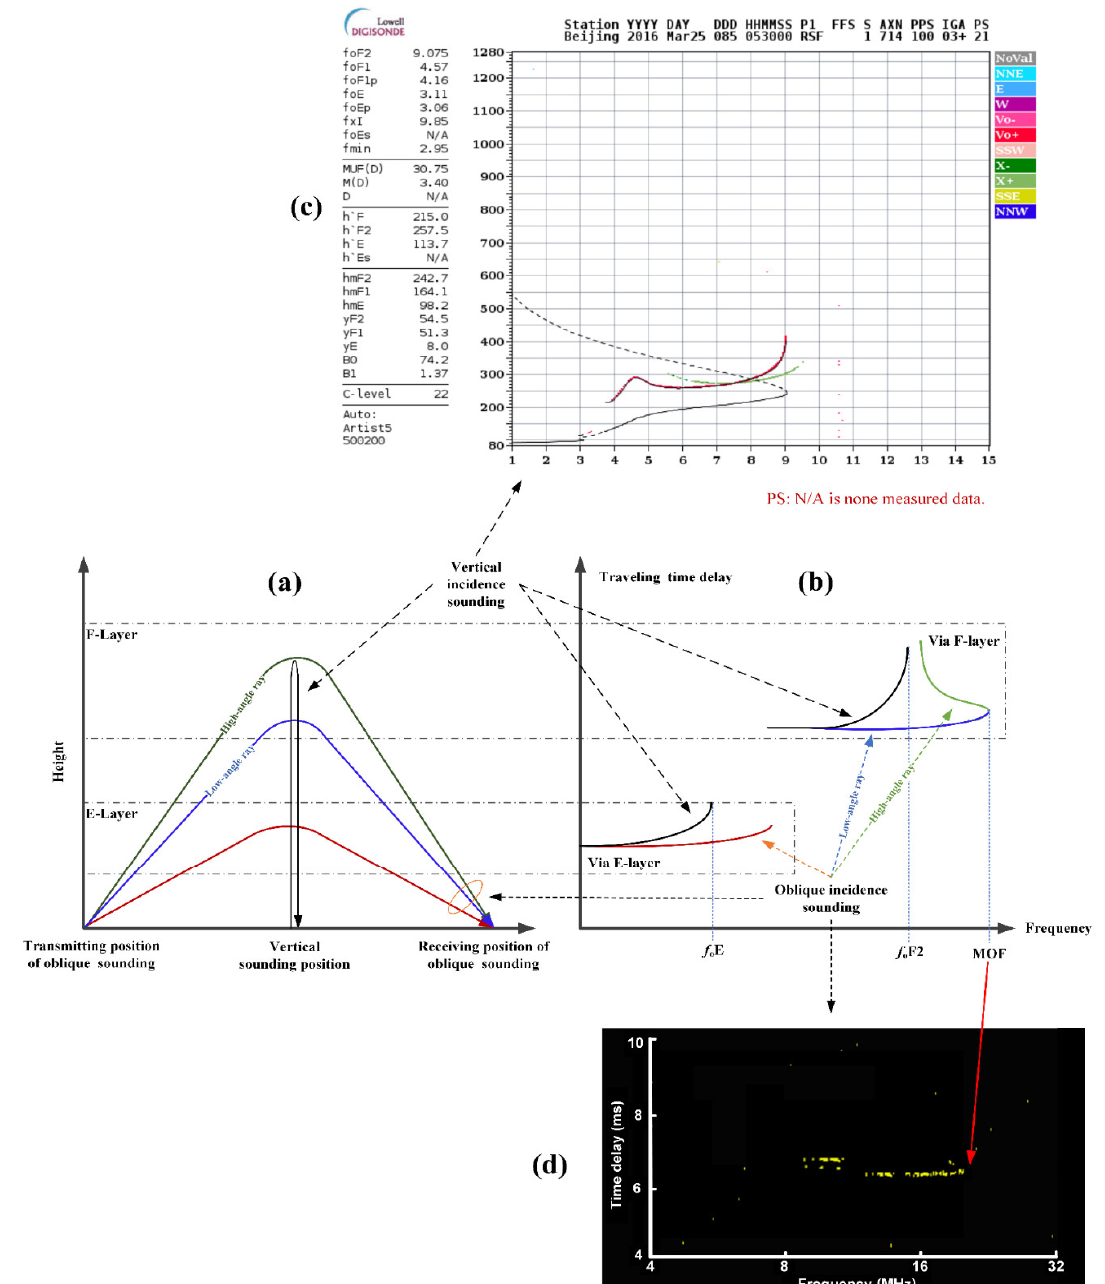
Figure 1. Principle and output results of the VI and OI sounding systems: ( a ) the VI and OI sounding principle; ( b ) formation principle of the VI and OI sounding ionograms; ( c ) an example of the VI ionograms from Beijing at 05:00, 25 March 2016; ( d ) an example of the OI ionograms from the Changchun-Jingyang circuit at 15:00, 1 December 2015.